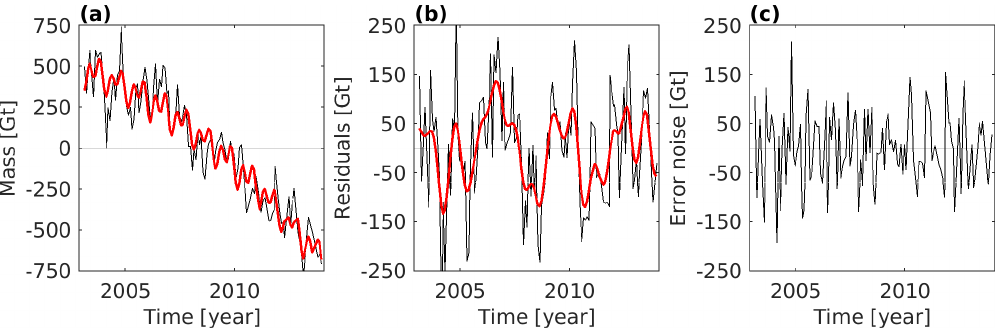
Figure 2. Procedure for quantifying the noise level in mass change time series. ( a ) Original mass change time series of the AIS (black) and the fitted linear, periodic (1yr, 1/2yr, 161/365.25yr) and quadratic model (red). ( b ) Mass change residuals (black), i.e., original mass change minus fitted model. Red line: Low-pass filtered residuals using a Gaussian average ( σ = 2.17months). ( c ) High-pass filtered residual, i.e., residuals minus low-pass filtered residuals. The noise assessment is based on the standard deviation of this time